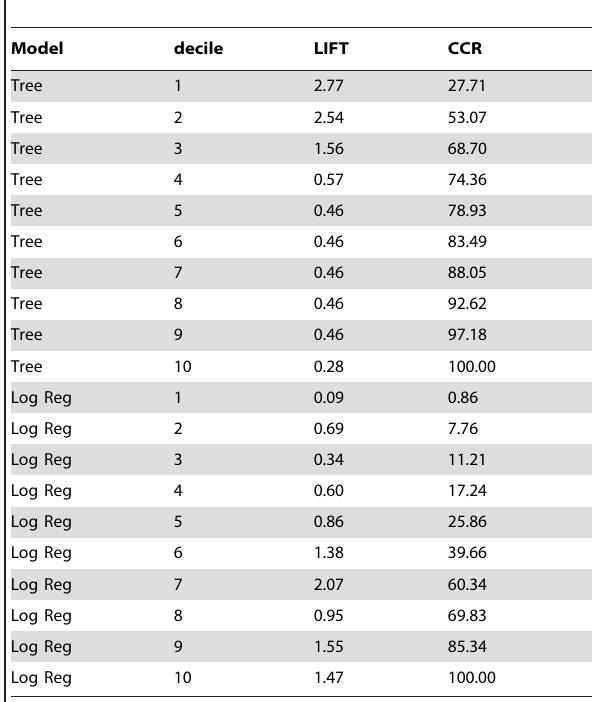
Table 5. Predictive models on the whole data